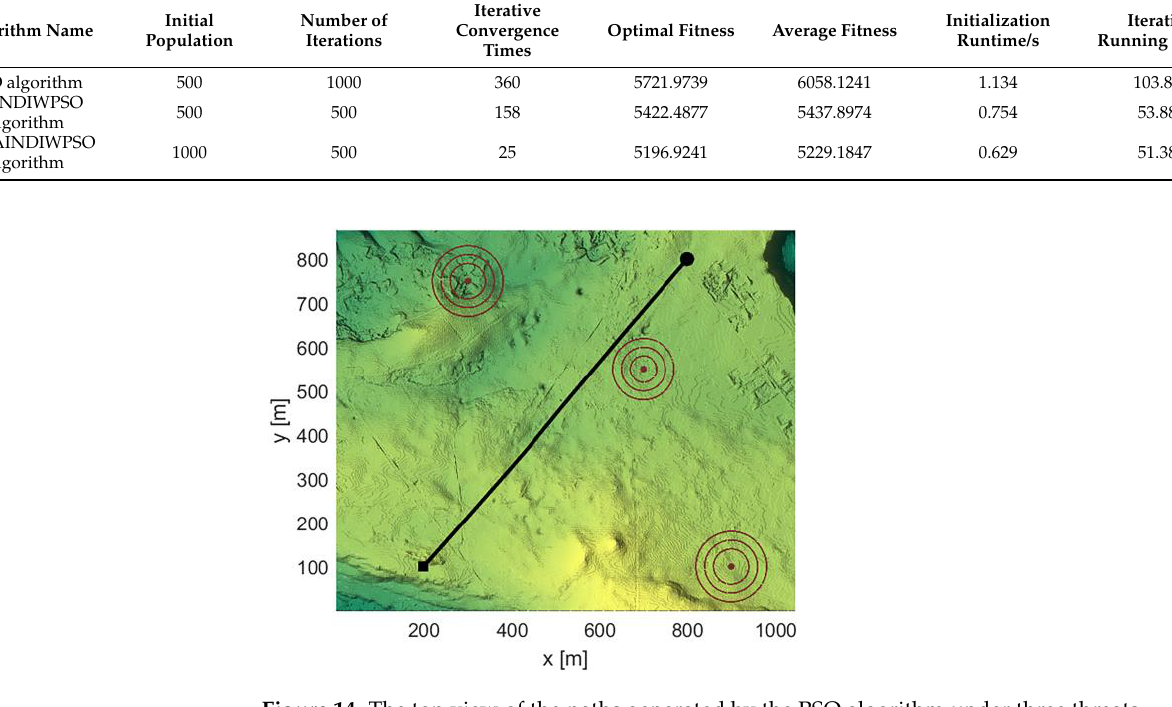
Figure 14. The top view of the paths generated by the PSO algorithm under three threats.